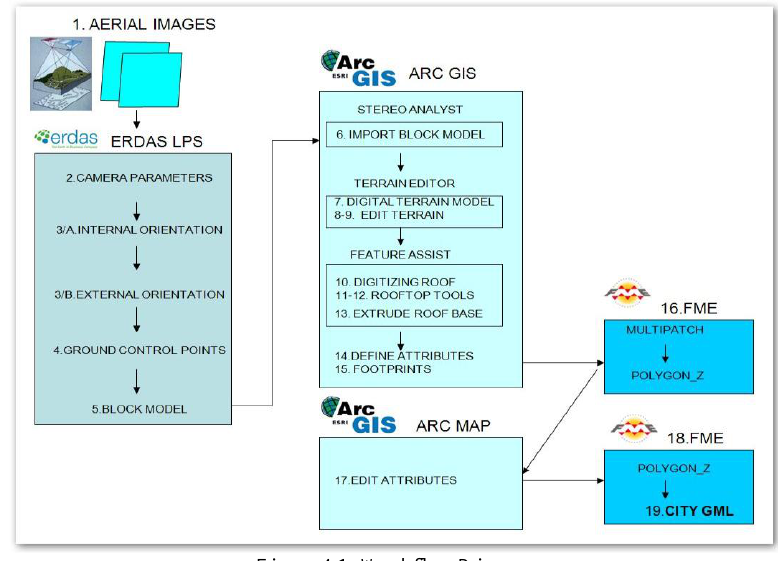
Figure 4.1: Workflow Diagram